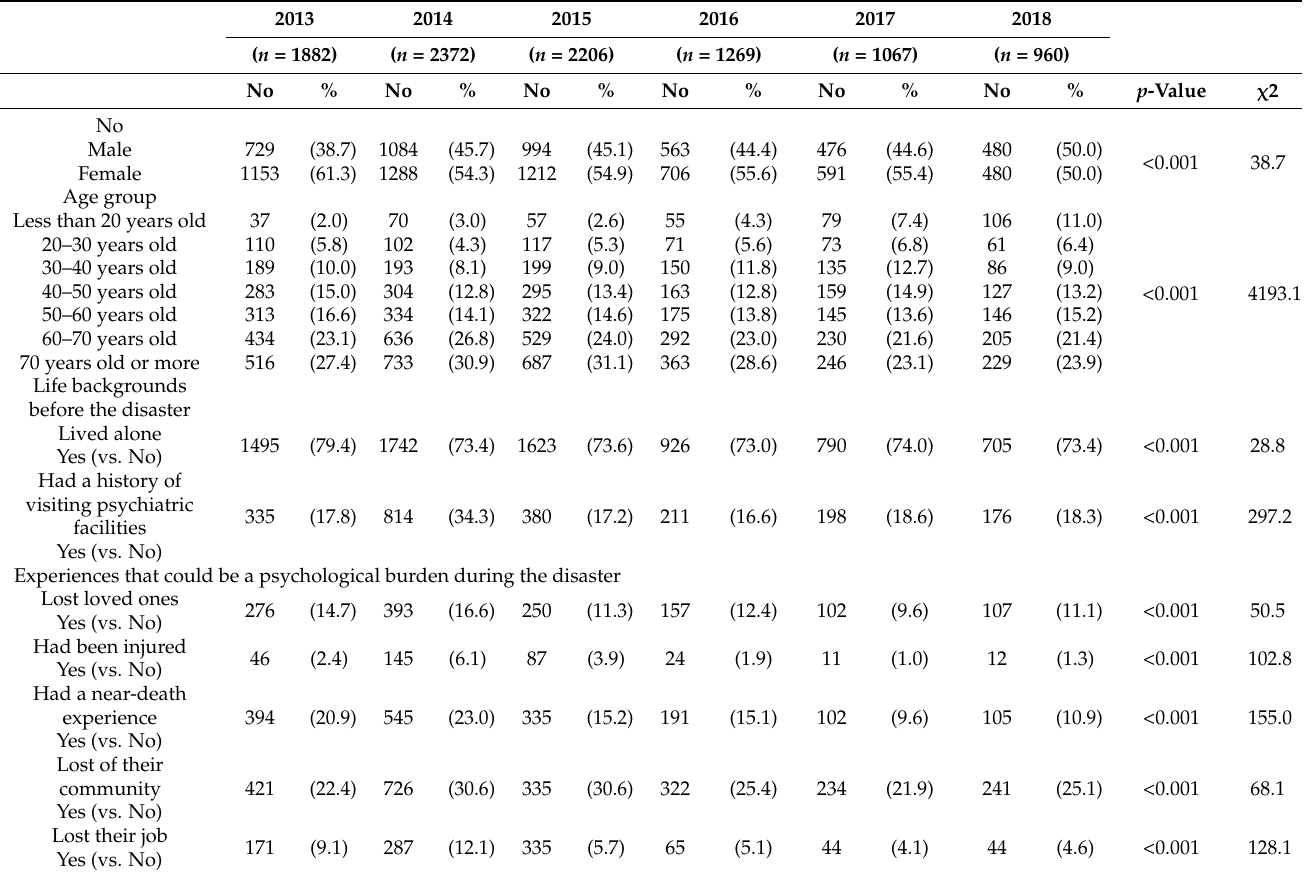
Table 1. The basic characteristics, life backgrounds before the disaster, and experiences that could be a psychological burden during the disaster of the residents.